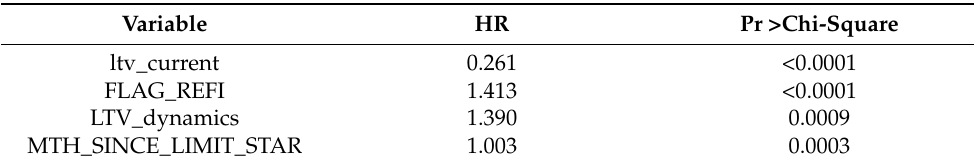
Table 3. Cox model results.